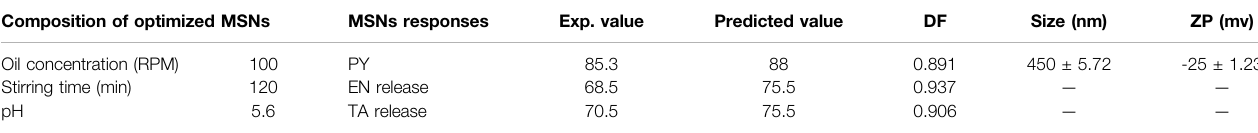
TABLE 4 | Level of components, experimental versus predicted results of PY, EN release, TA release, desirability factor, size, and ZP of optimized MSNs. Composition of optimized